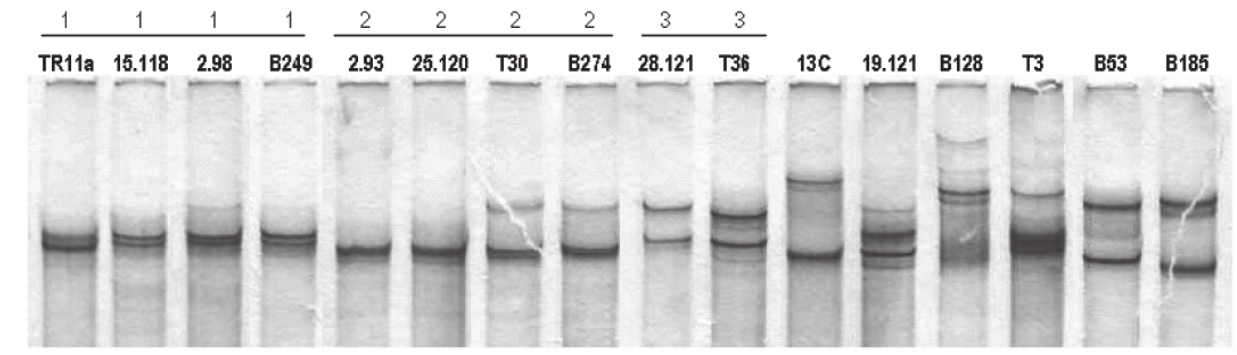
Fig. 4. SSCP patterns of the 16 cloned standards. SSCP groups are marked 1 to